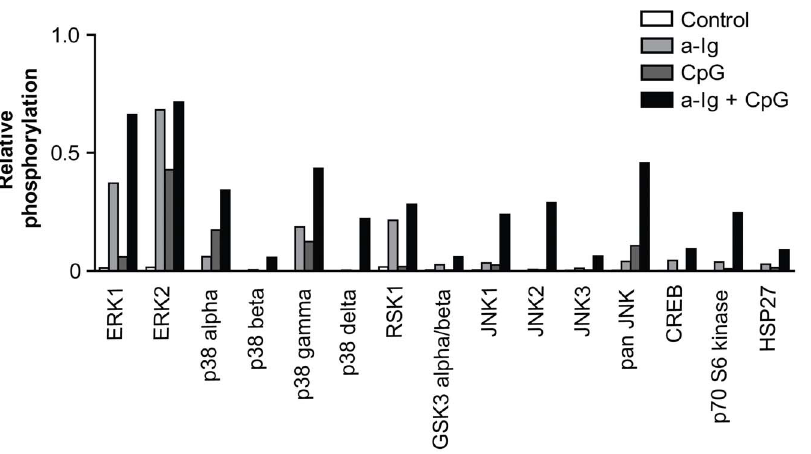
Figure 1. Screening of BCR and TLR9 stimulated kinase activation pattern in BJAB Burkitt’s lymphoma cells by MAPK protein profiler array. BJAB cells were treated with 5 m g/ml anti-Ig and/or 2 m g/ml CpG for 30 minutes. Relative phosphorylation values were calculated as the ratios of signal strengths for each kinases as compared to positive control spots. Only kinases that were activated are shown.